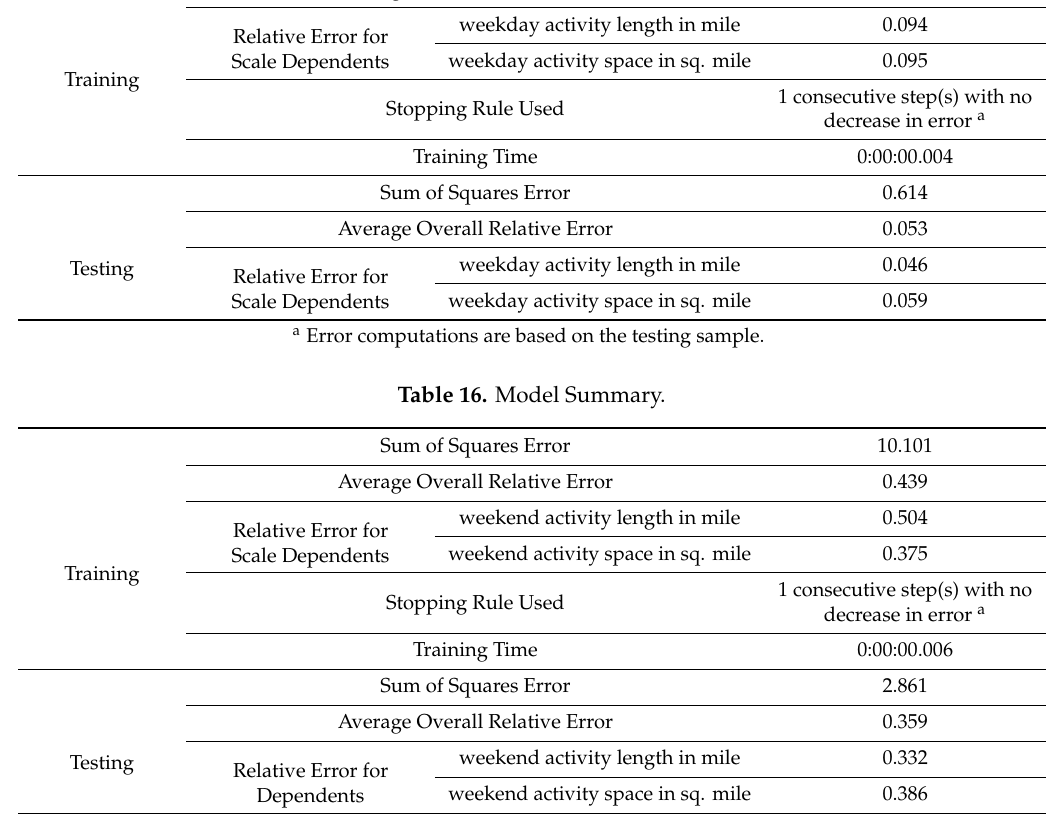
Table 15. Model Summary.